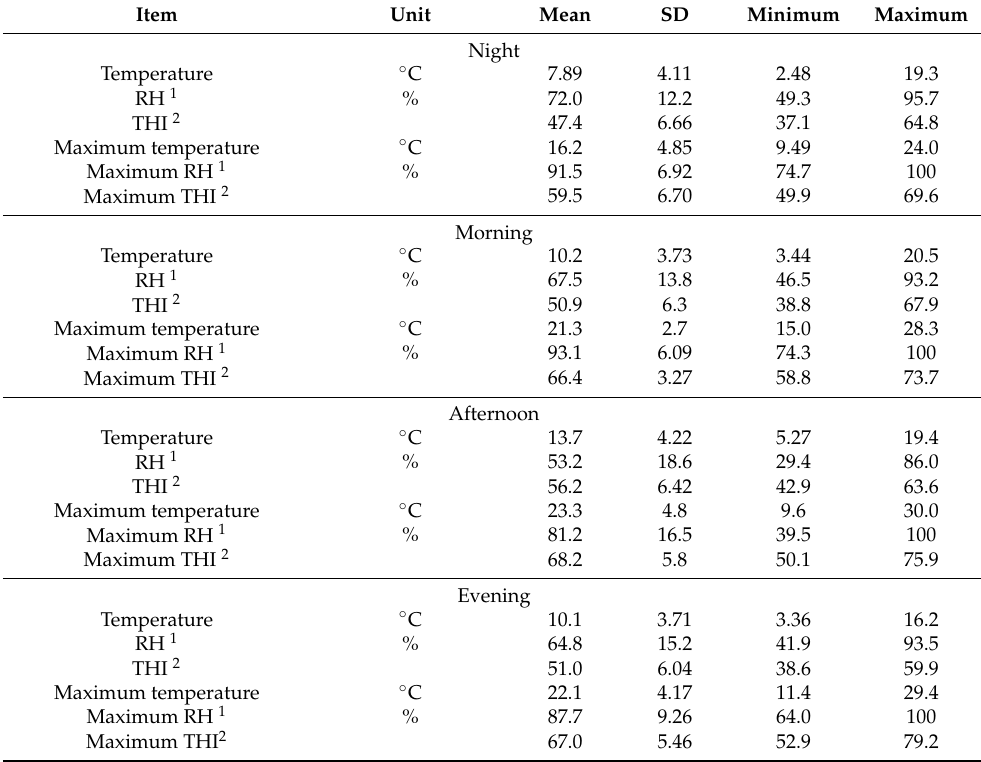
Table 3. Microclimatic conditions in calf pens ( n =